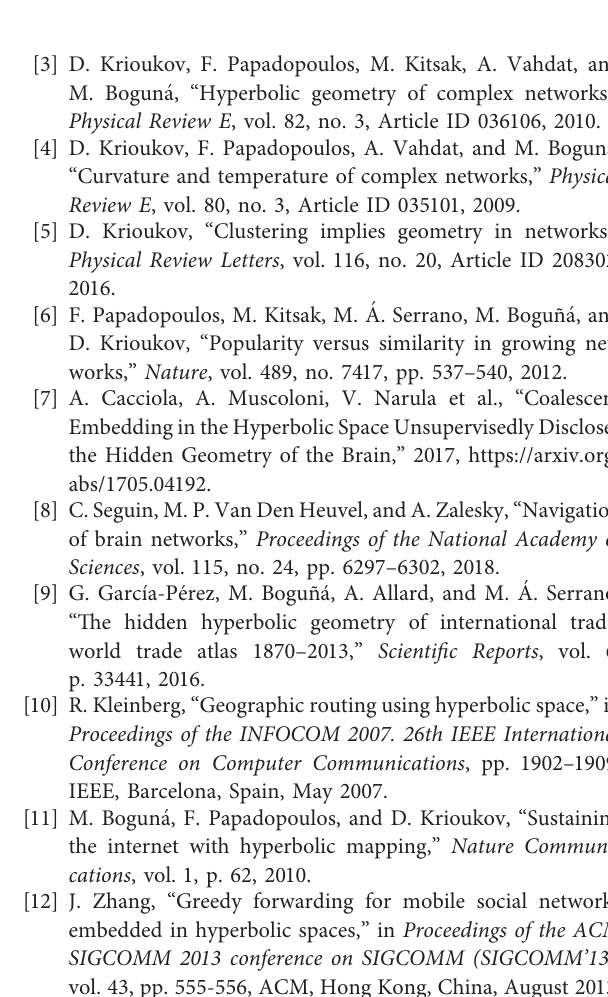
Figure 6: Testing the embedding method in synthetic networks. (a, b) Inferred angular coordinates vs. real ones for the 100 most connected nodes in the synthetic hyperbolic network with 167 nodes. The exponents of power-law degree distribution ( c parameter β is set as 3.5. The average degree is set as